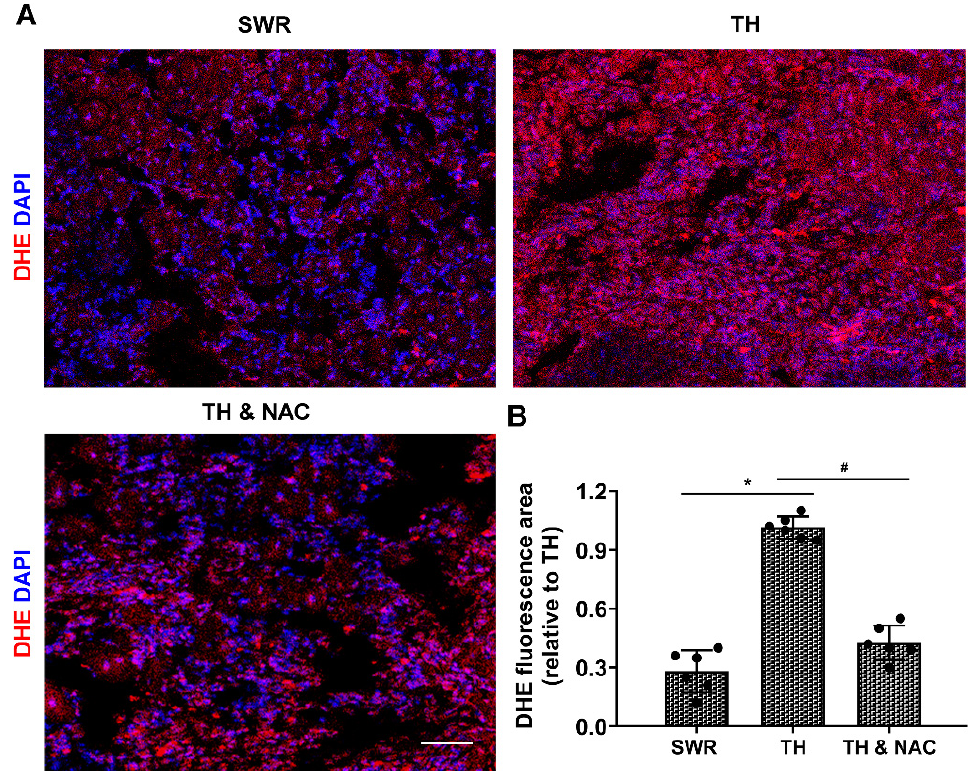
Figure 5. NAC treatment prevented ROS overproduction in diabetic ischemic limb. Detection of in situ ROS production was performed both in the ischemic limb of diabetic and non-diabetic mice using DHE staining. Tissue ROS levels in diabetic ischemic limb were significantly increased compared to the non-diabetic ischemic limb at day 21 after CLI (TH versus SWR 1.01/0.28, * p < 0.01, A , B ), whereas NAC treatment significantly prevented the increase of ROS production in diabetic ischemic limbs (TH versus TH & NAC 1.01/0.43, # p < 0.01, A , B ). DAPI, 4 ′ ,6-diamidino-2-phenylindole; DHE, fluorescent dye dihydroethidium; TH, diabetic TALLYHO/JngJ mice with CLI operation; SWR, non-diabetic SWR/J mice with CLI operation; TH & NAC, TALLYHO/JngJ mice with CLI operation plus NAC treatment. Scale bar, 50 µ m. All data are shown as means ± SD; n = 6/group. Significant differences were determined with one-way ANOVA with Bonferroni’s post hoc test.